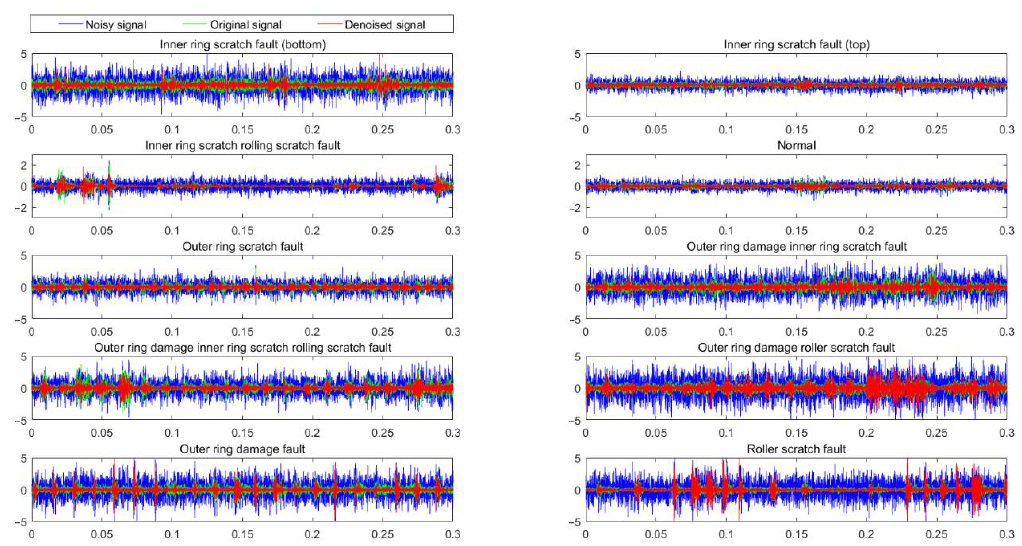
Figure 16. Vibration signals in 10 different